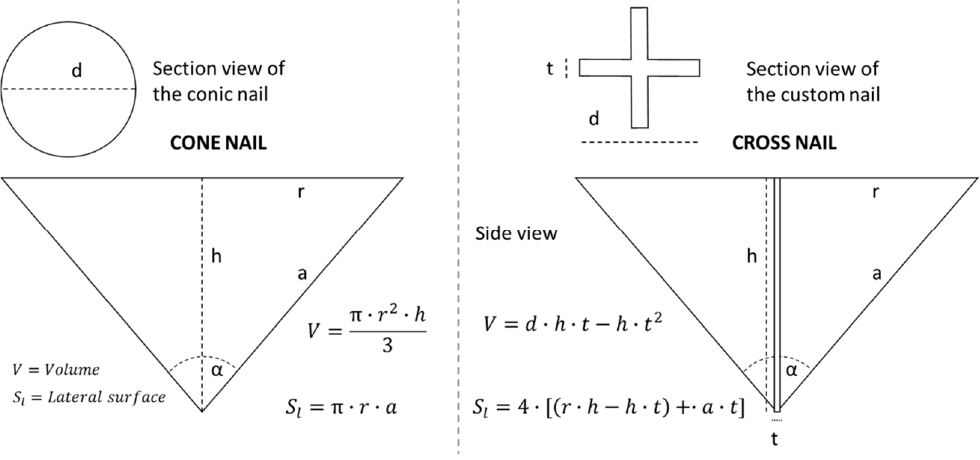
Figure 4. Geometrical comparison of the external surface and the volume for the conical and cross- shaped nail. Next to the geometries are specified the equations used for the calculation of the external surface and the object volume. Table 2. Comparison of the lateral surface areas and volumes for the conical and cross-shaped